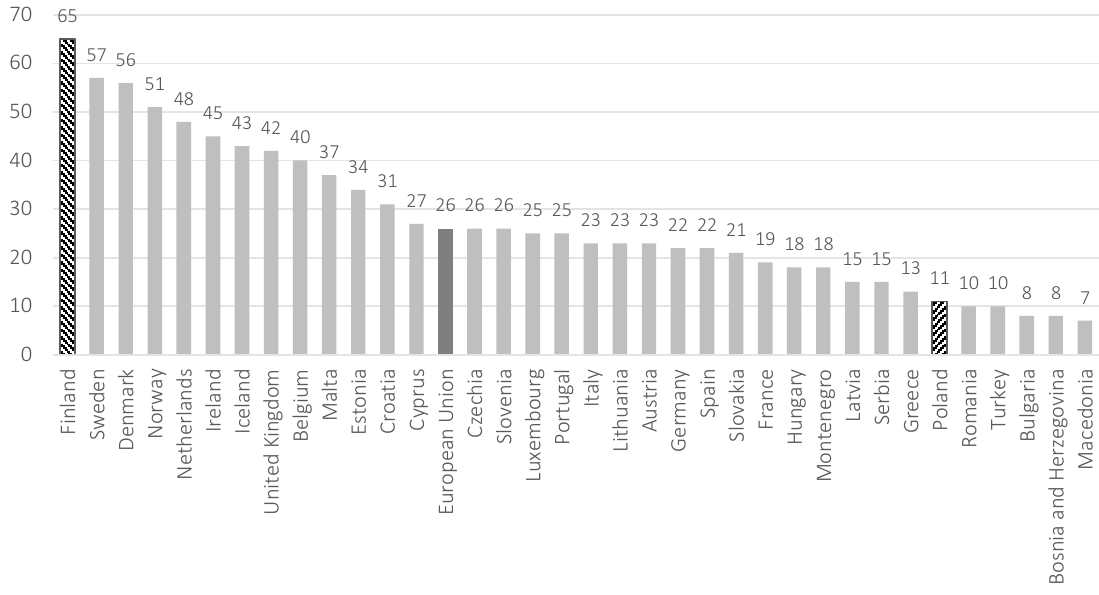
Source: Developed by the author based on Eurostat